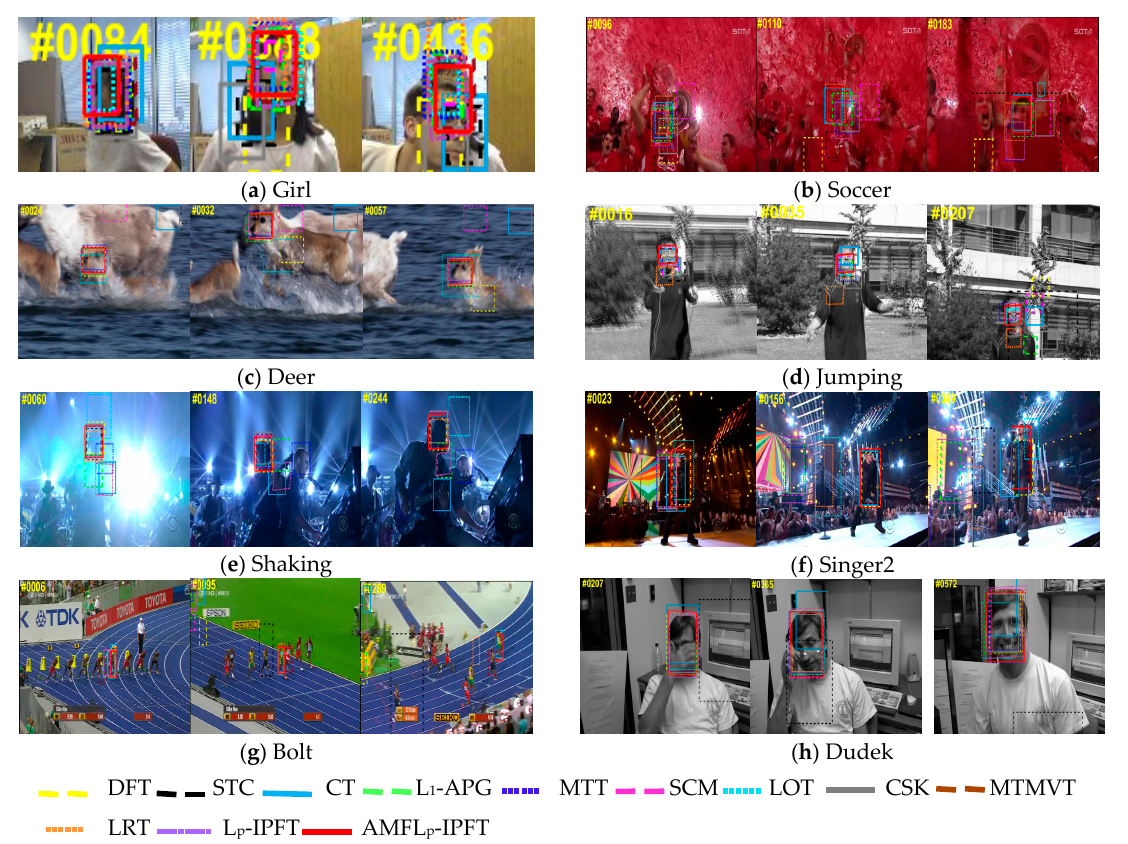
Figure 5. Four groups of tracking results corresponding to different trackers.